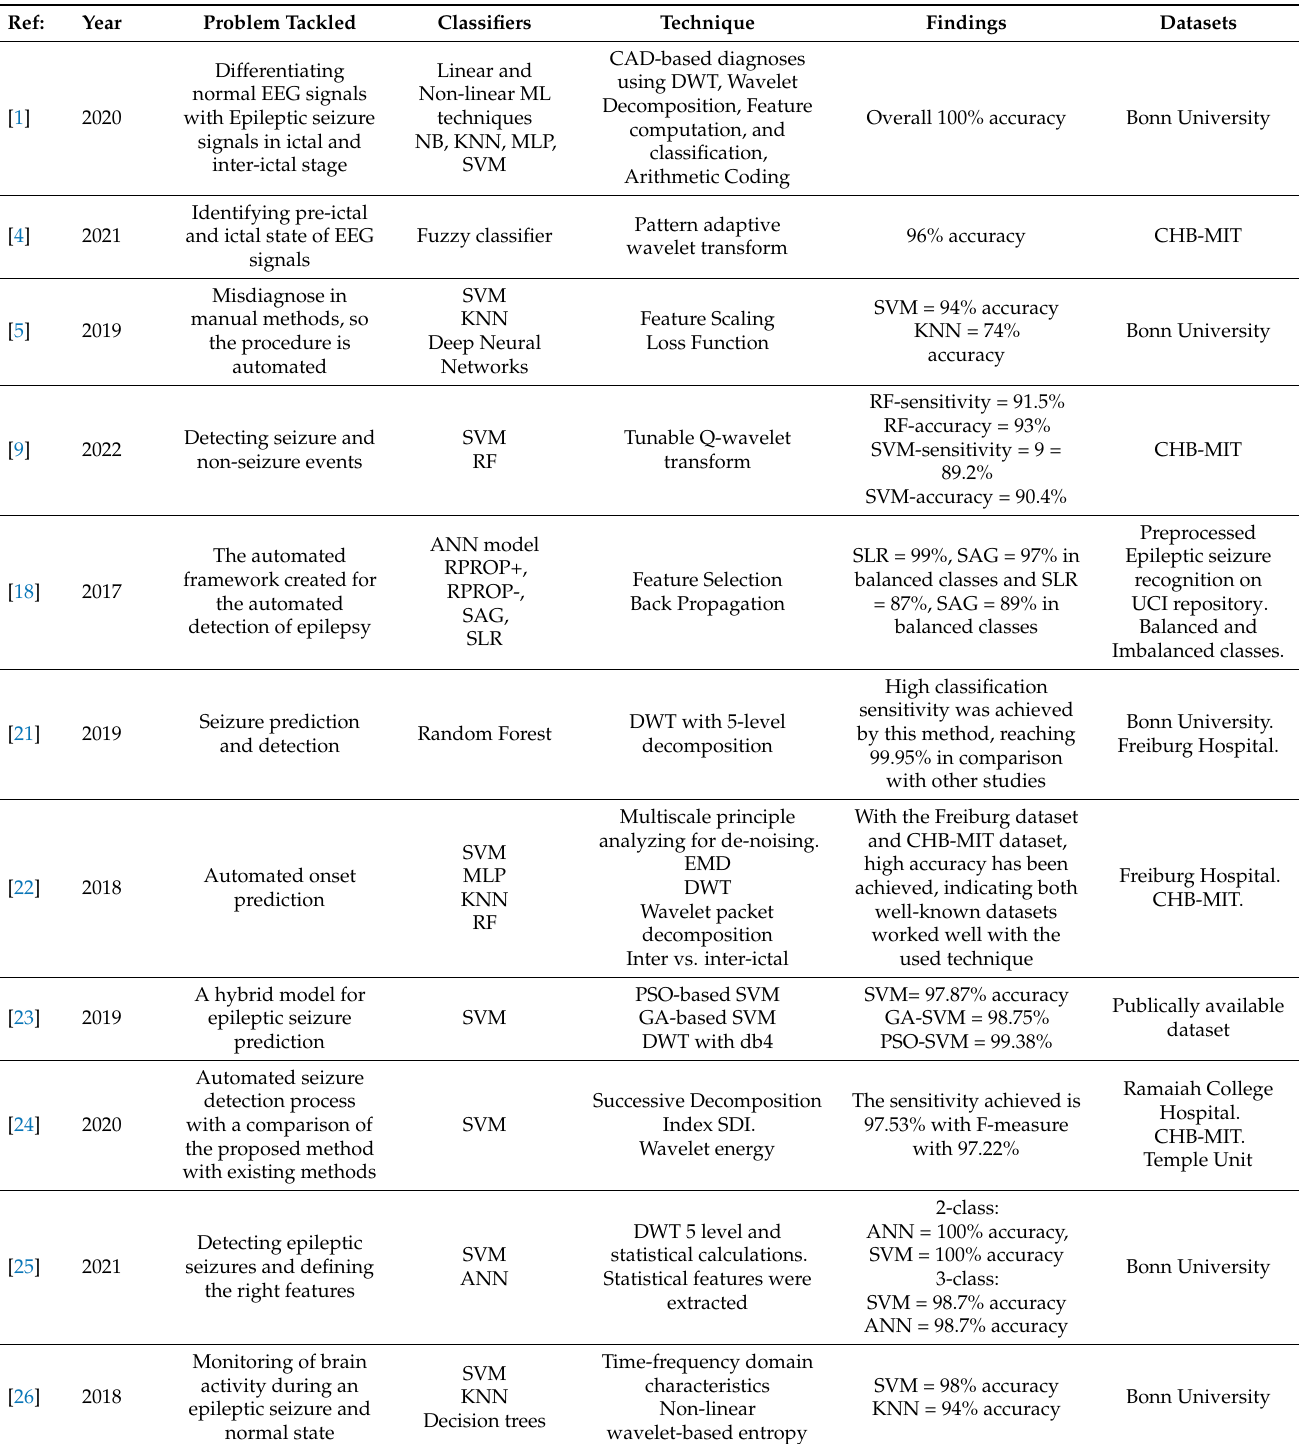
Table 4. Classification